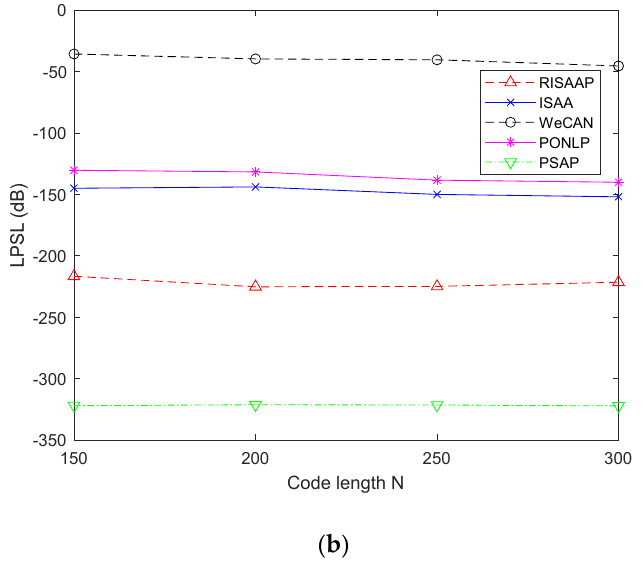
Figure 3. Aver-ACL and LPSL comparison with different code lengths N . ( a ) Aver-ACL comparison of RISAAP, ISAA, WeCAN, PONLP, and PSAP. ( b ) LPSL comparison of RISAAP, ISAA, WeCAN, PONLP, and PSAP. Table 2. Performance comparison for suppressing multiple area sidelobes with different weights.